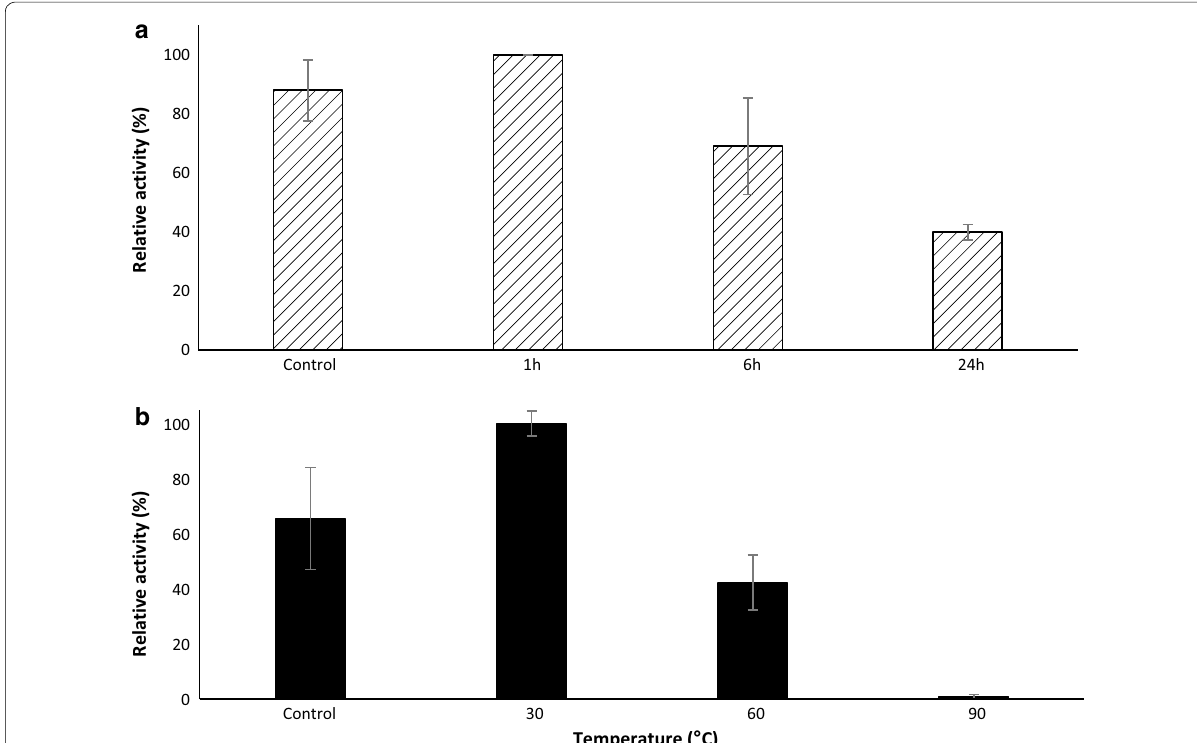
Fig. 4 The pH ( a ) and thermal ( b ) stability profiles of Sc Lac. a We incubated 0.4 µM Sc Lac in the optimal pH buffer for 1, 6 and 24 h at 30 °C and the residual activity was measured using 20 µM DMP. b We incubated 0.4 µM Sc Lac at 30, 60 and 90 °C for 1 h in the optimal pH buffer and the residual